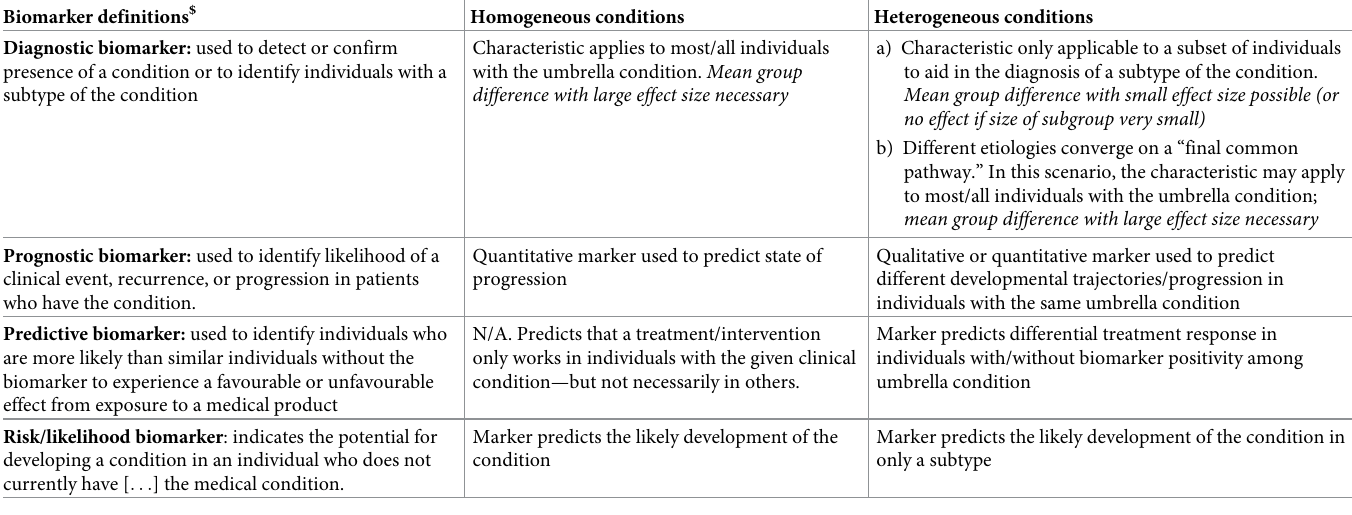
Table 1. Biomarkers in homogeneous vs. heterogeneous